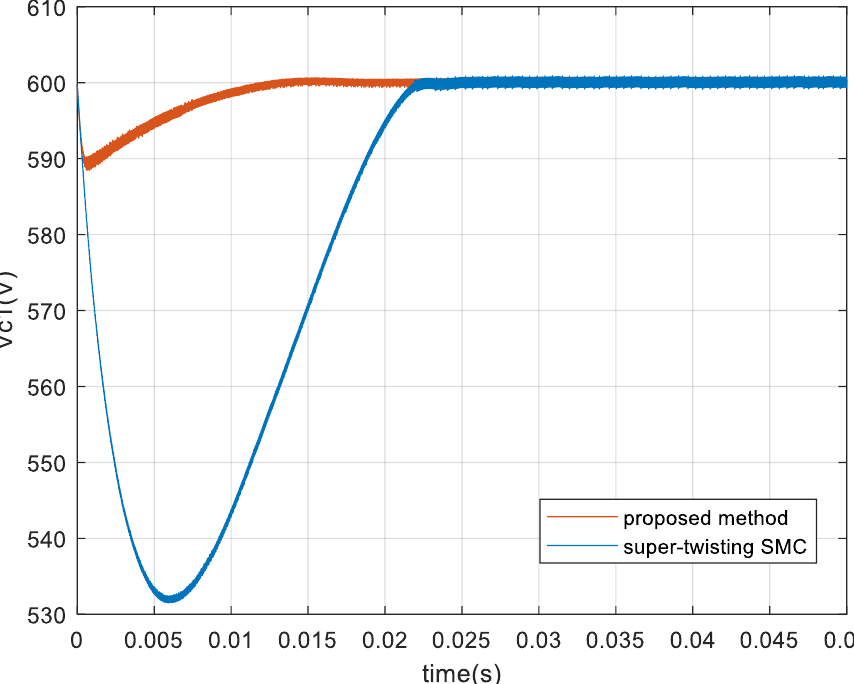
Figure 14. Comparison of bus voltage simulation results of the two SMC methods.